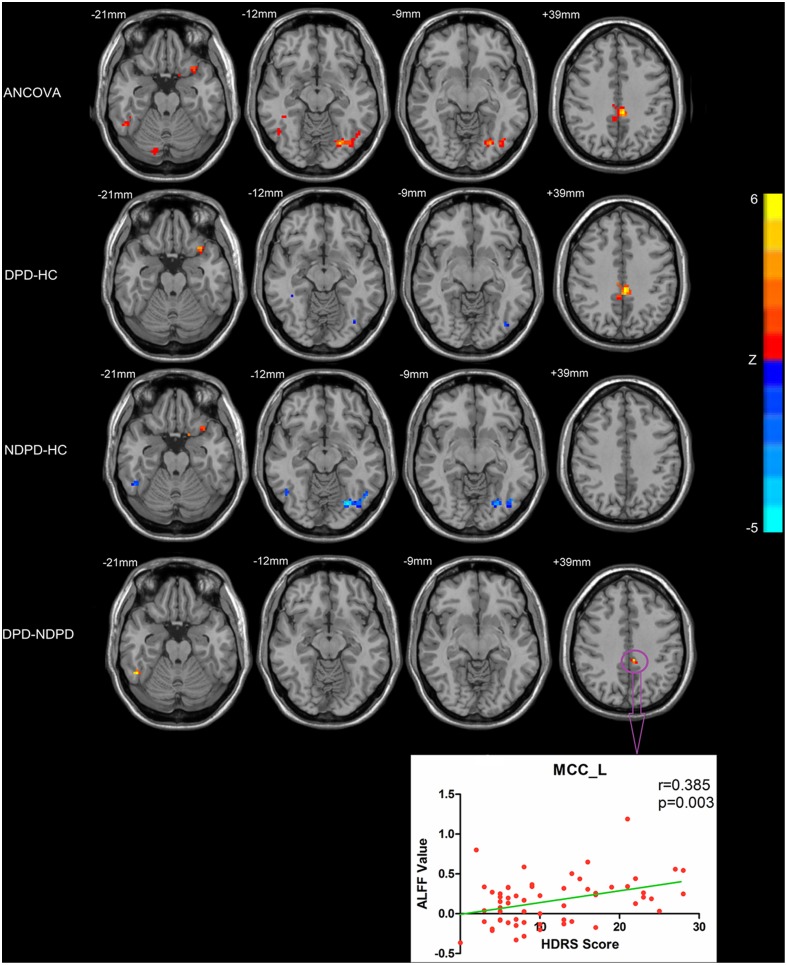
Statistical parametric map showing the significant differences in the ALFF between three groups: DPD, NDPD and HC.The ANCOVA thresholds were set at a voxel-level p < 0.01, cluster size > 918 mm3 /34 voxels, corresponding to a corrected p < 0.05 as determined by AlphaSim correction. A two-sample post hoc t-test was performed between each pair of the three groups (DPD vs NDPD, DPD vs HC, NDPD vs HC)(voxel-level p < 0.01, cluster size > 162 mm3 /6 voxels, corresponding to a corrected p < 0.05 as determined by AlphaSim correction). Statistical parametric map showing the significant correlations between HAMD score and ALFF value in left MCC.